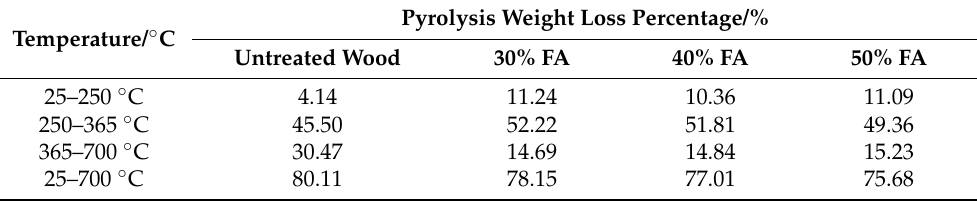
Figure 9. TG ( a ) and DTG ( b ) curves of untreated and furfurylated wood.